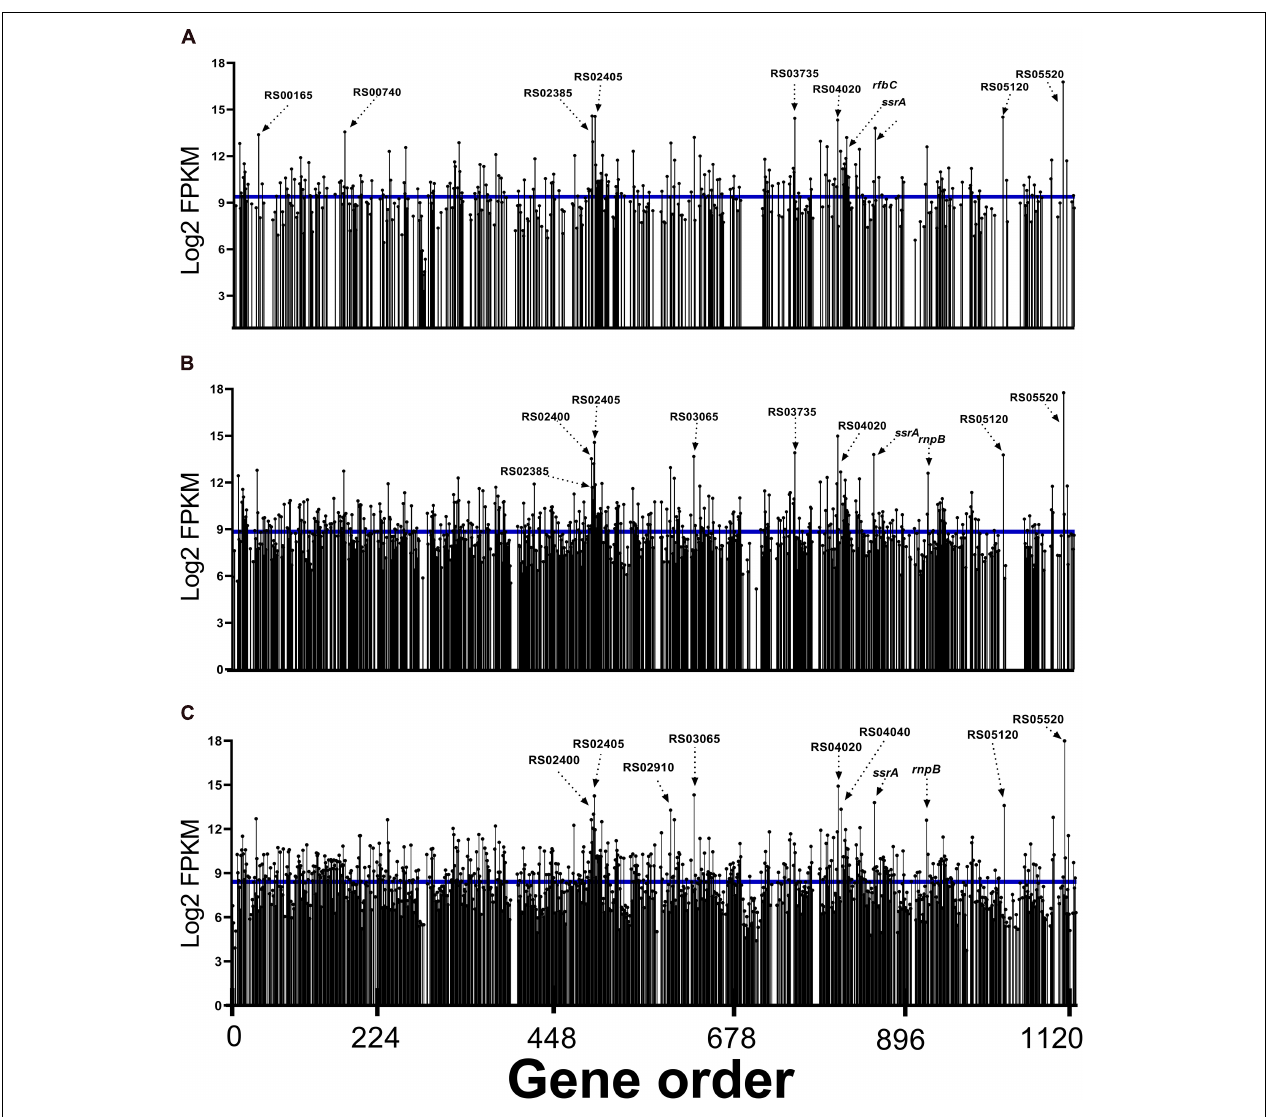
FIGURE 2 | Read abundance mapped to “ Candidatus Liberibacter asiaticus” genes (reference strain JXGC, NZ_CP019958.1) expressed in gut samples from Diaphorina citri after acquisition access periods of 1/2 days (Las I) (A) , 3/4 days (Las II) (B) , or 5/6 days (Las III) (C) , mean